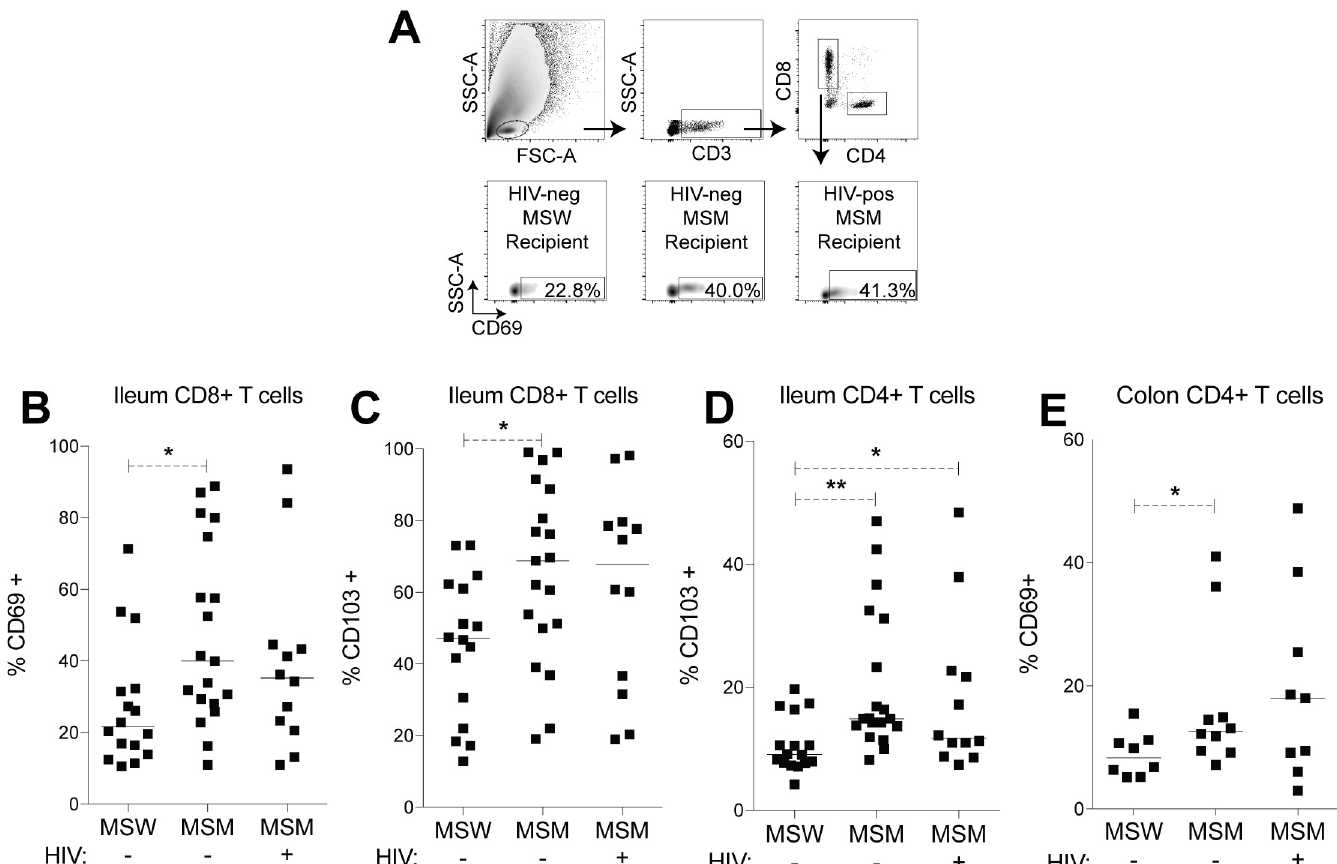
Fig 3. Gut T cell activation and homing in mouse recipients. Ileum and colon tissues were collected from mouse recipients at 21 days post gavage and analyzed for frequencies of CD69+ and CD103+ T cells. (A) Gating strategy for CD69+ T cells. Representative plots from ileum tissues are shown. (B-C) Frequencies of (B) CD69 + CD8+ T cells, (C) CD103+ CD8+ T cells, and (D) CD103+ CD4+ T cells in the ileum. (E) Frequencies of CD69+ CD4+ T cells in the colon. Each data point represents a single mouse gavaged with an individual donor’s feces, and a representative mouse was used for stools tested in replicate mice. Lines represent medians. Statistical analyses were performed using t-tests to compare groups if data from both groups had normal distributions and Mann-Whitney tests to compare groups if data from at least one group had a non-parametric distribution. �� = p < 0.01, � = p < 0.05.